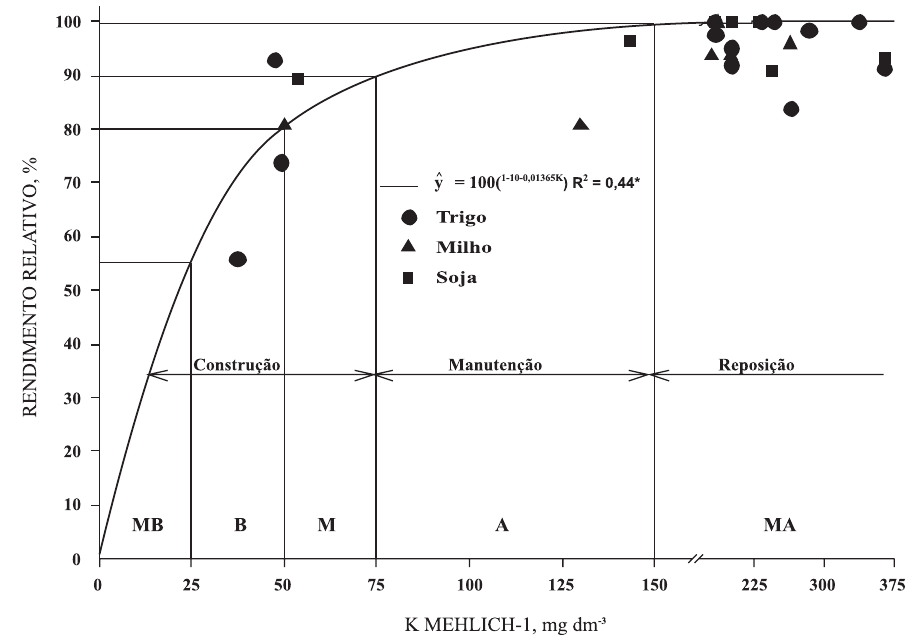
Figura 1. Relação entre potássio pelo extrator Mehlich-1 e o rendimento relativo obtido com trigo, milho e soja, equação de produção, coeficiente de correlação, teor crítico e faixas de fertilidade para K sob sistema plantio direto. Significativo (p <